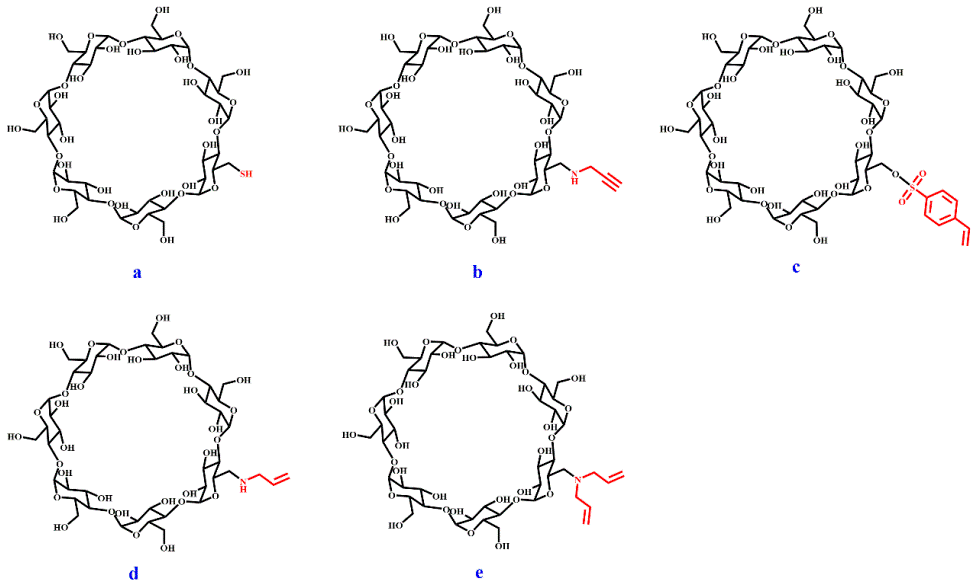
Figure 9. Molecular structure of five functional monomers of cyclodextrin derivatives. ( a ) mono-(6-mercapto-6-deoxy)- β -CD ( β -CD-1); ( b ) mono-(6- N -propargyl-6-deoxy)- β -CD ( β -CD-2); ( c ) mono-(6- O -p-vinylbenzene sulfonyl-6-deoxy)- β -CD ( β -CD-3); ( d ) mono-(6- N -allylamino-6-deoxy)- β -CD ( β -CD-4); ( e ) mono-(6- N -diallylamine-6-deoxy)- β -CD ( β -CD-5).